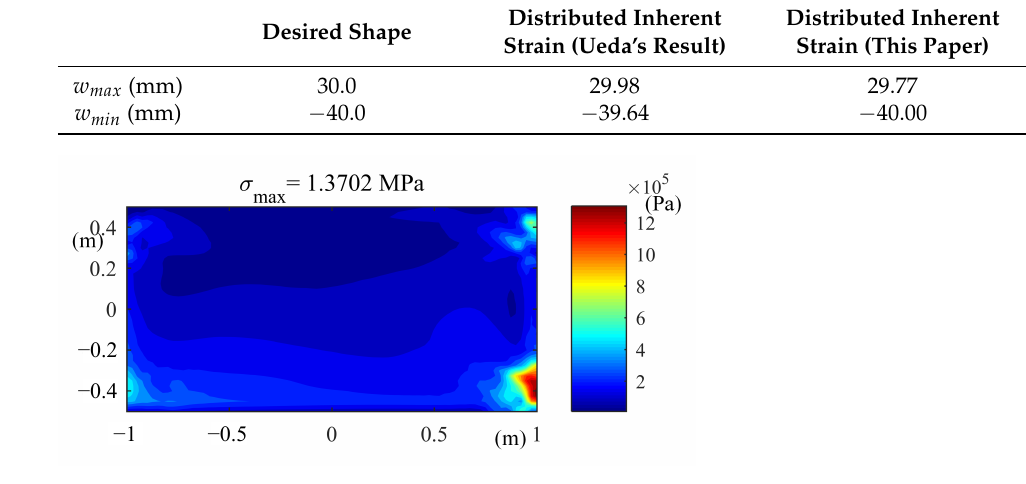
Figure 14. Mises stress with inherent strain applied to a free